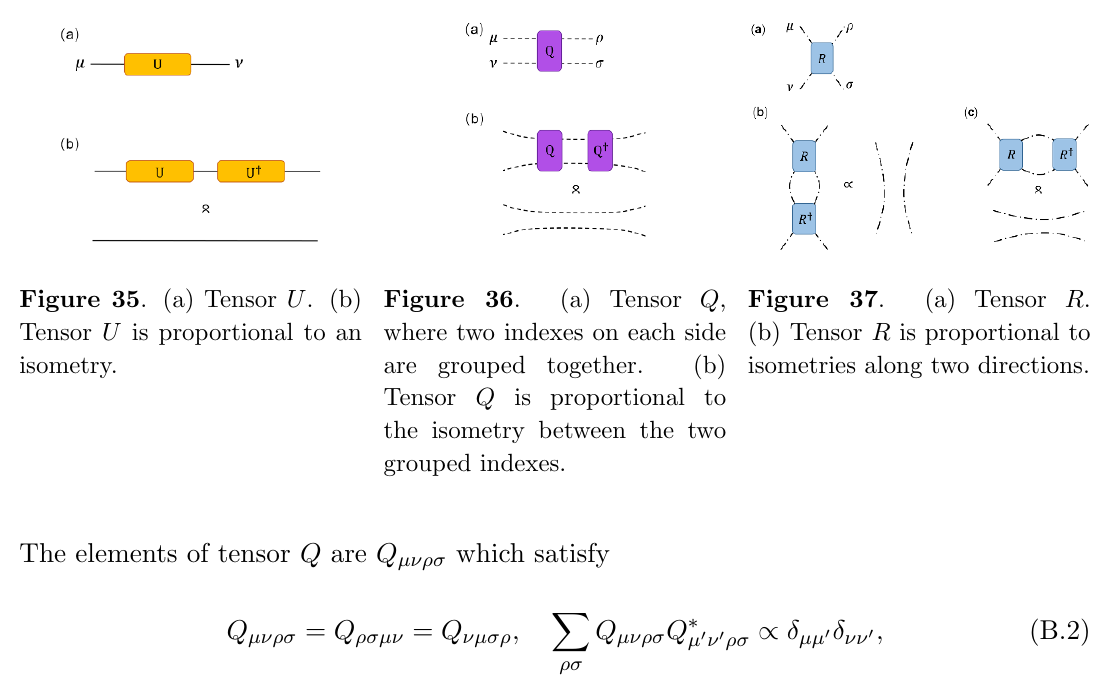
Figure 34 . Circle (green), horocircles (red) and hypercircles (blue and black) in H 2 space. Those hypercircles share the same axis (black). They are symmetric under the re(cid:13)ection with respect to their axis.